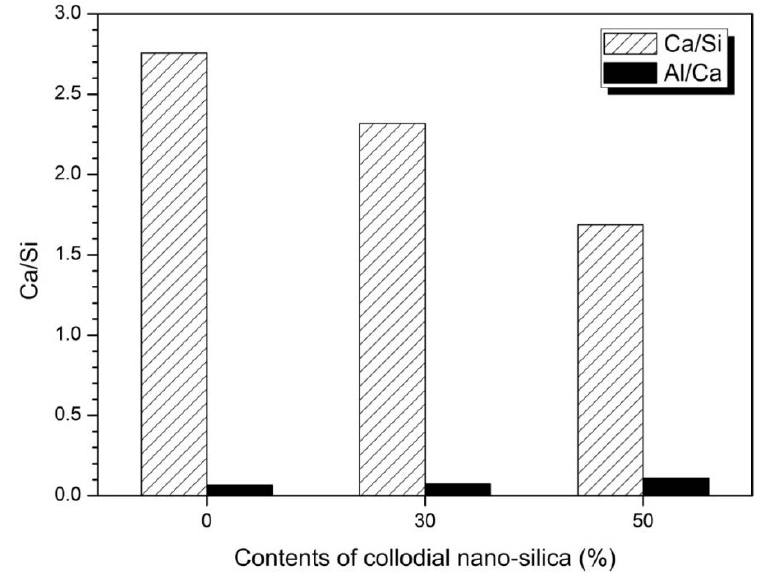
Figure 9. Atomic ratios of the hydration products.